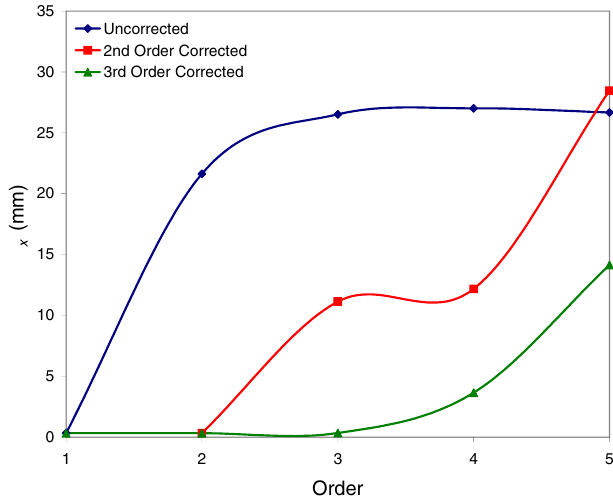
FIG. 7. (Color) Standard deviation of the horizontal beam size evaluated at different orders before and after aberration correc-